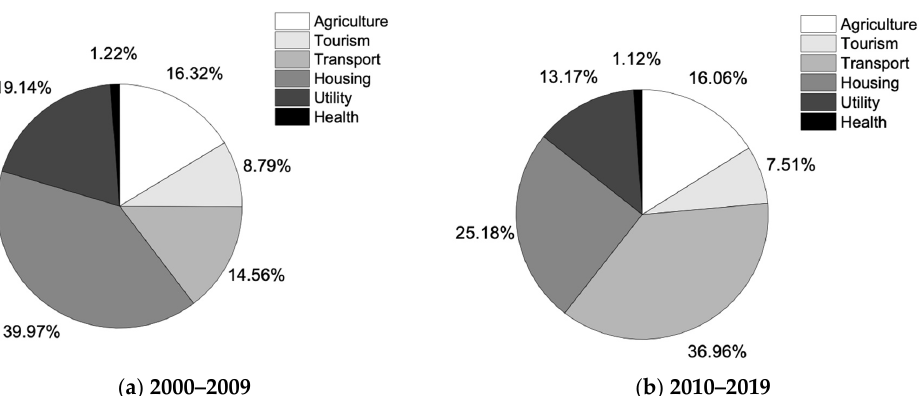
Figure 5. Loss and damage incurred from the selected Caribbean Countries (St. Vincent and